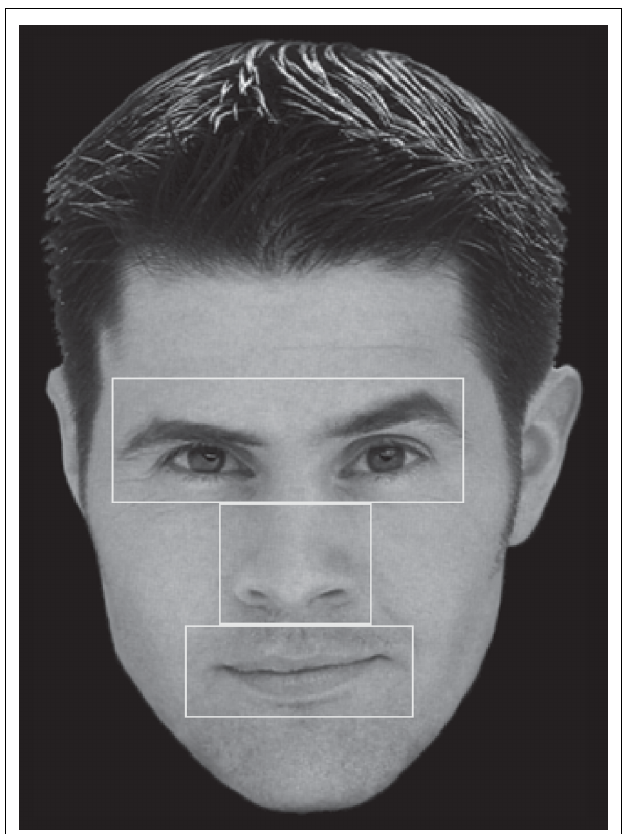
FIGURE 1 |An example of a non-famous face overlaid with its unique interest area template. All interest area templates captured features in the same manner depicted. During the experiment, stimuli were presented in color and without interest area template overlaid.